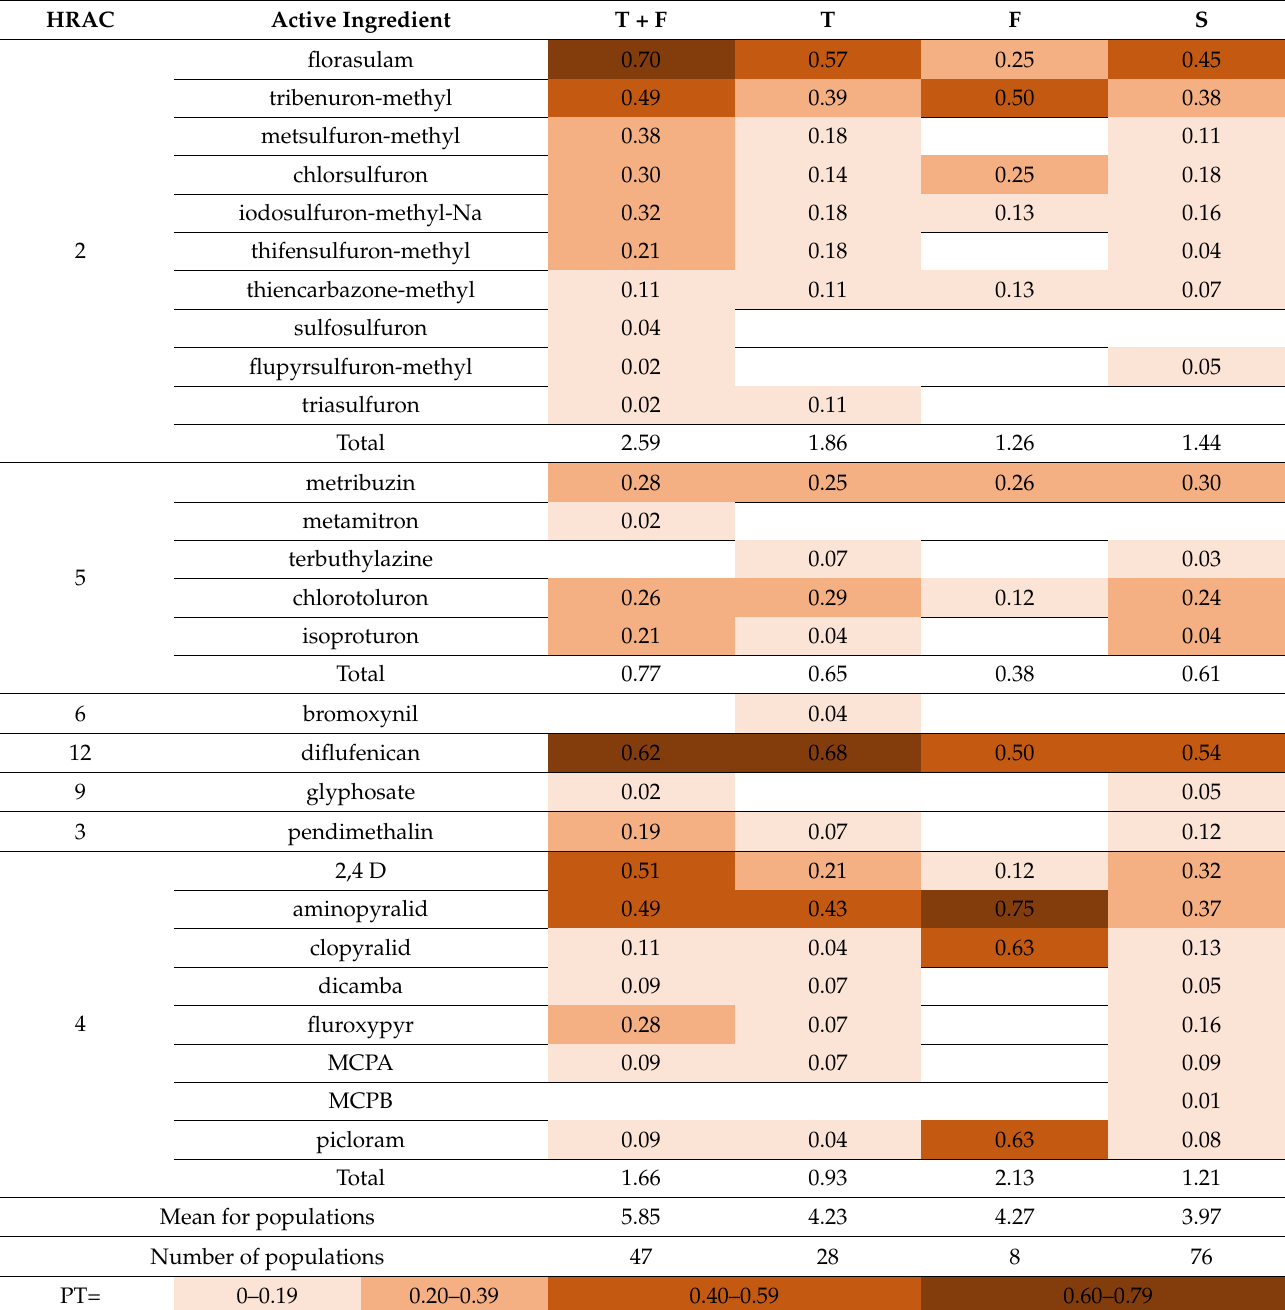
Table 2. Population treatment (PT) of the herbicide active ingredient in crop fields with Centaurea cyanus populations resistant to acetolactate synthase inhibitors (HRAC 2) (r and R) and susceptible (S) in two or three successive growing